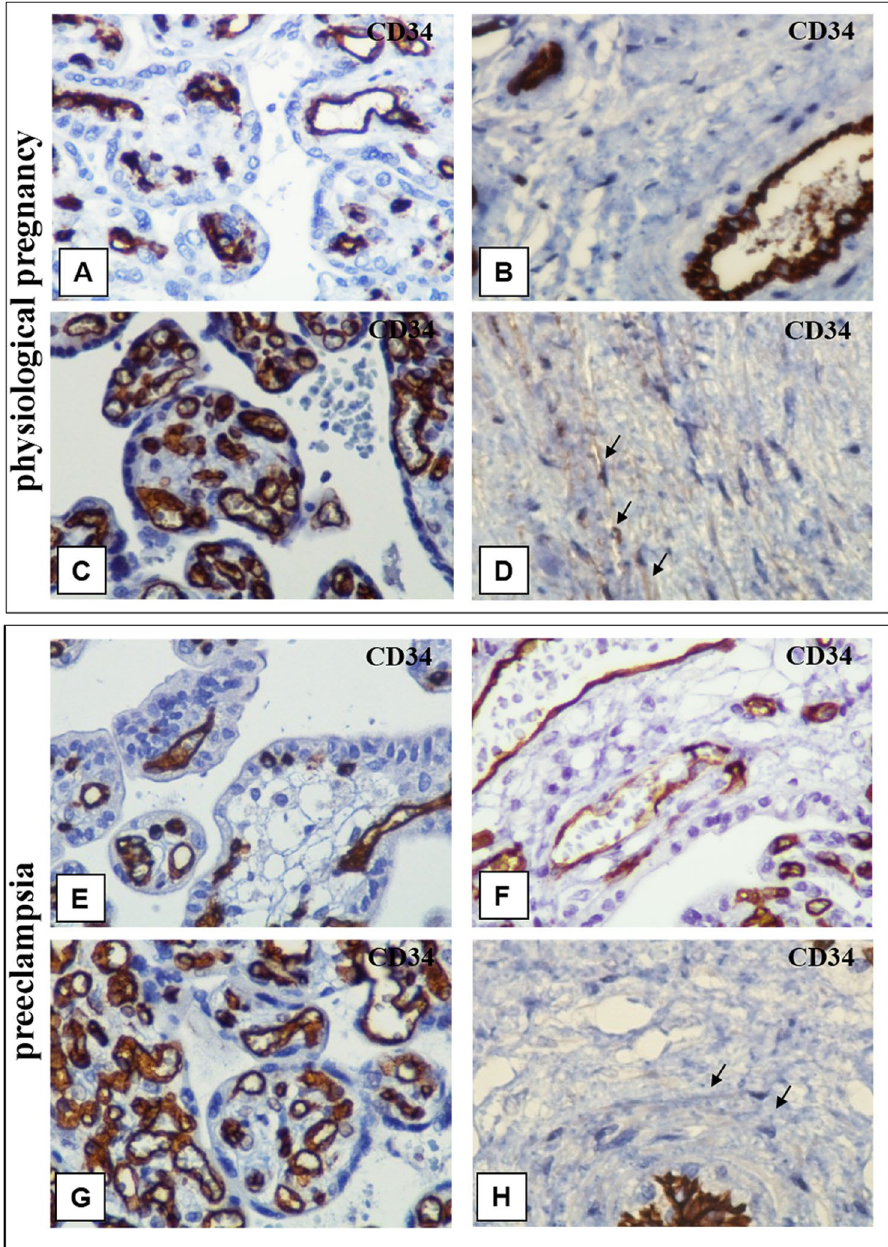
Figure 4. Immunohistochemical staining of placental villi with primary antibodies to CD34 in preeclampsia and physiological pregnancy. ( А–D ) Placental villous tree in a physiological pregnancy. ( А ) Placenta at the 27 th week (intermediate villi dominate), х400. ( B ) Stem villi at the 27 th week (the staining is not observed in the stroma), х600. ( С ) Intermediate villi at the 39 th week (only the staining of vascular endothelium is observed), х400. ( D ) Stem villi at the 39 th week (myofibroblasts are stained in the stem villus wall indicated with arrows), х600. ( E ) Intermediate placenta villi in early-onset PE (at the 27 th week) (a lot of stromal channels with circulating macrophages are shown in some intermediate villi; vascular endothelium staining is only observed; staining in not detected in the villous stroma), х400. ( F ) In early-onset PE (at the 33 th week), the stromal channels remain in the stem villi stroma (vascular endothelium staining is observed), х600. ( G ) Intermediate villi in late-onset PE (at the 38 th week) (only vascular endothelium staining is observed), х400. ( H ) Stem villi in late-onset PE (at the 38 th week) are not completely formed; single telocytes are stained weakly and the stromal channels are still present in them (indicated with arrows),